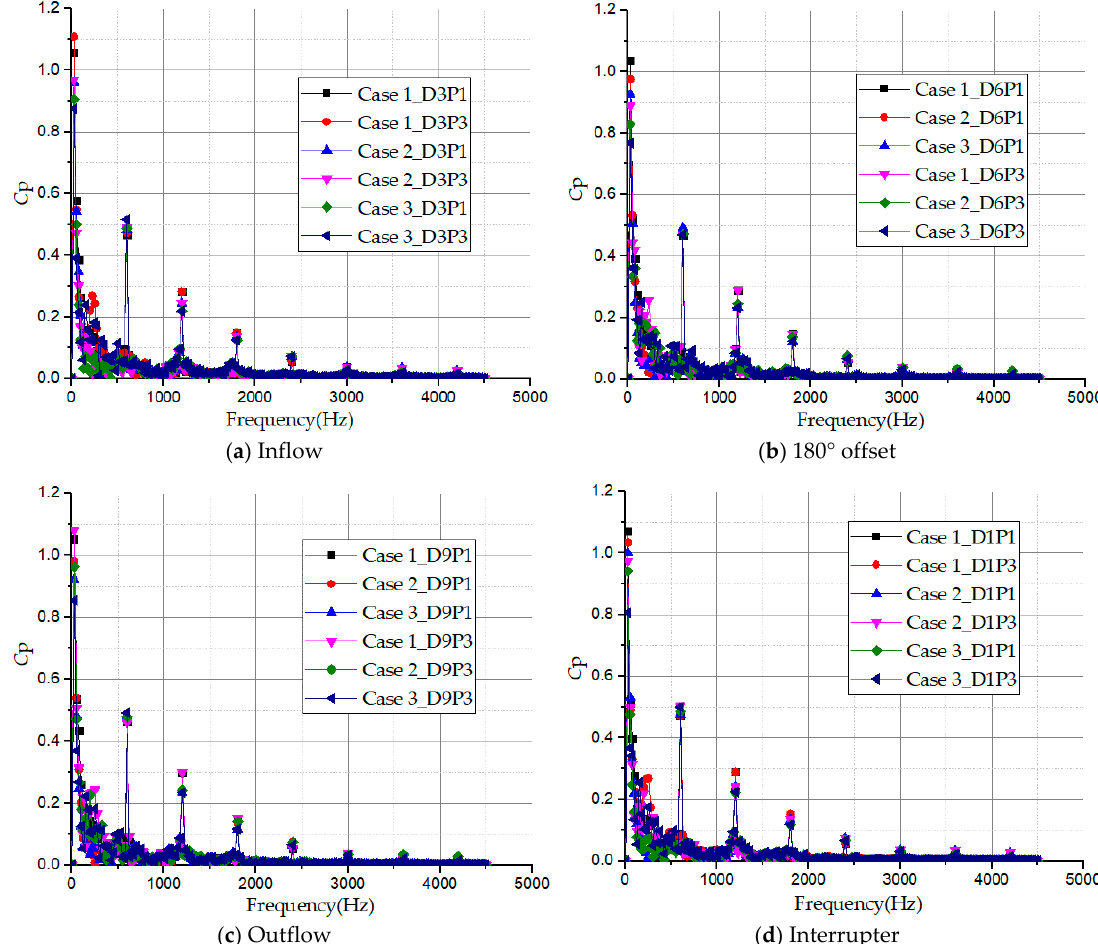
Figure 18. Frequency domain history of pressure fluctuation in impeller passage for three pump cases.